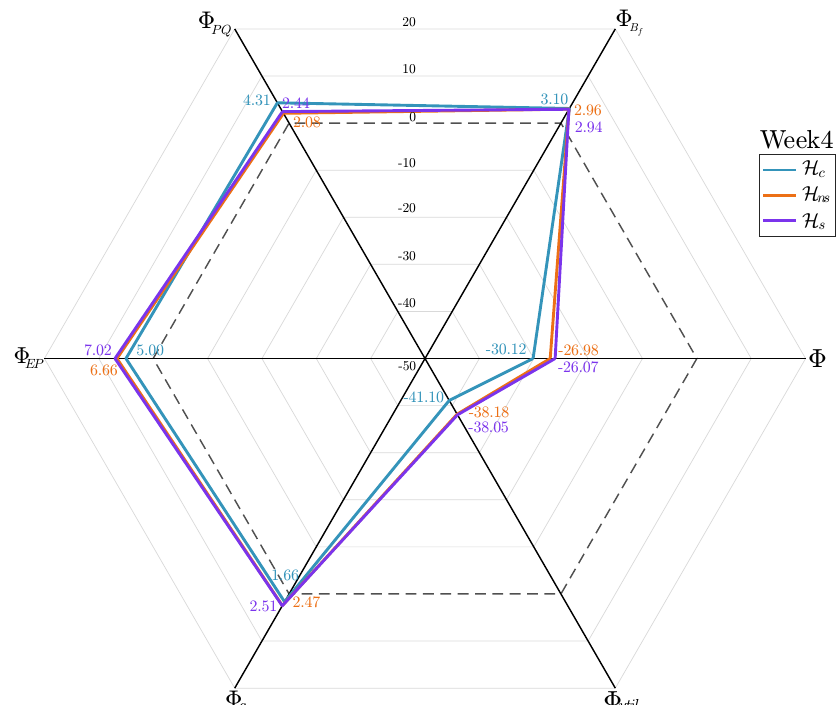
Figure 8. Energy operation economic result for Week